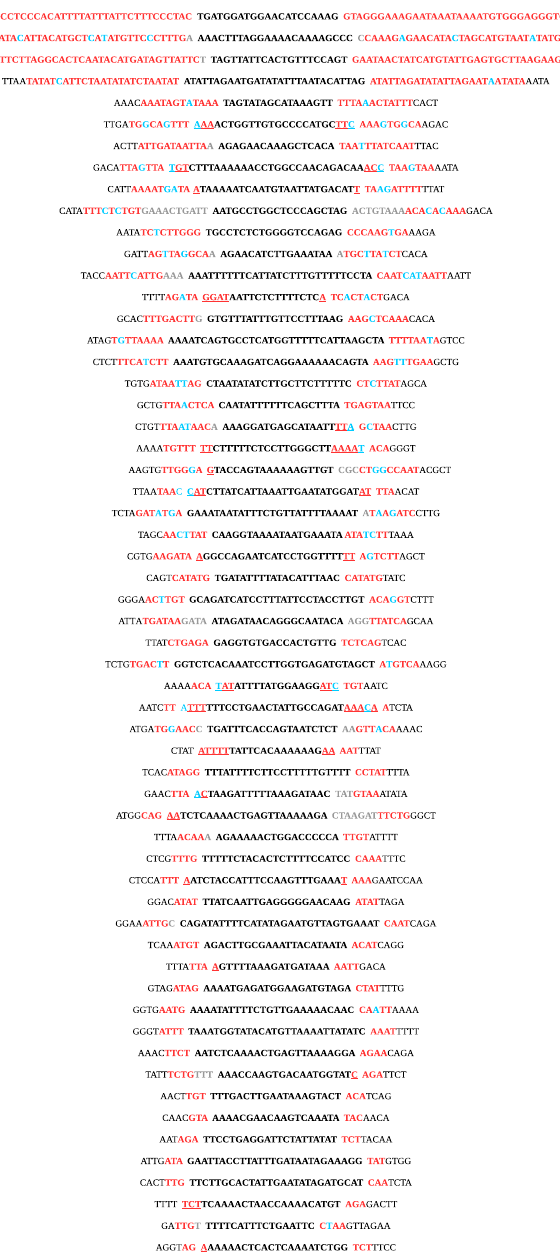
Figure 2. Definite microinversions between human and chimpanzee genomes are always flanked by inverted repeats. Microinversion sequences are shown in bold black font; inverted repeats are shown in red bold font, and their overlaps with microinversions are underlined; mismatches within inverted repeats are shown in blue bold font; sequences separating microinversions from inverted repeats are shown in grey bold font; sequences external to inverted repeats are shown in regular black